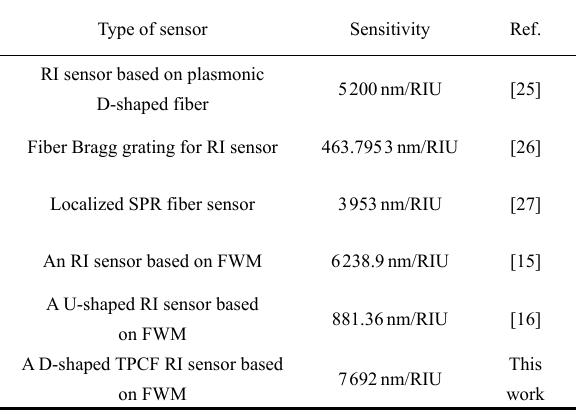
Table 1 Comparison with predecessors. Type of